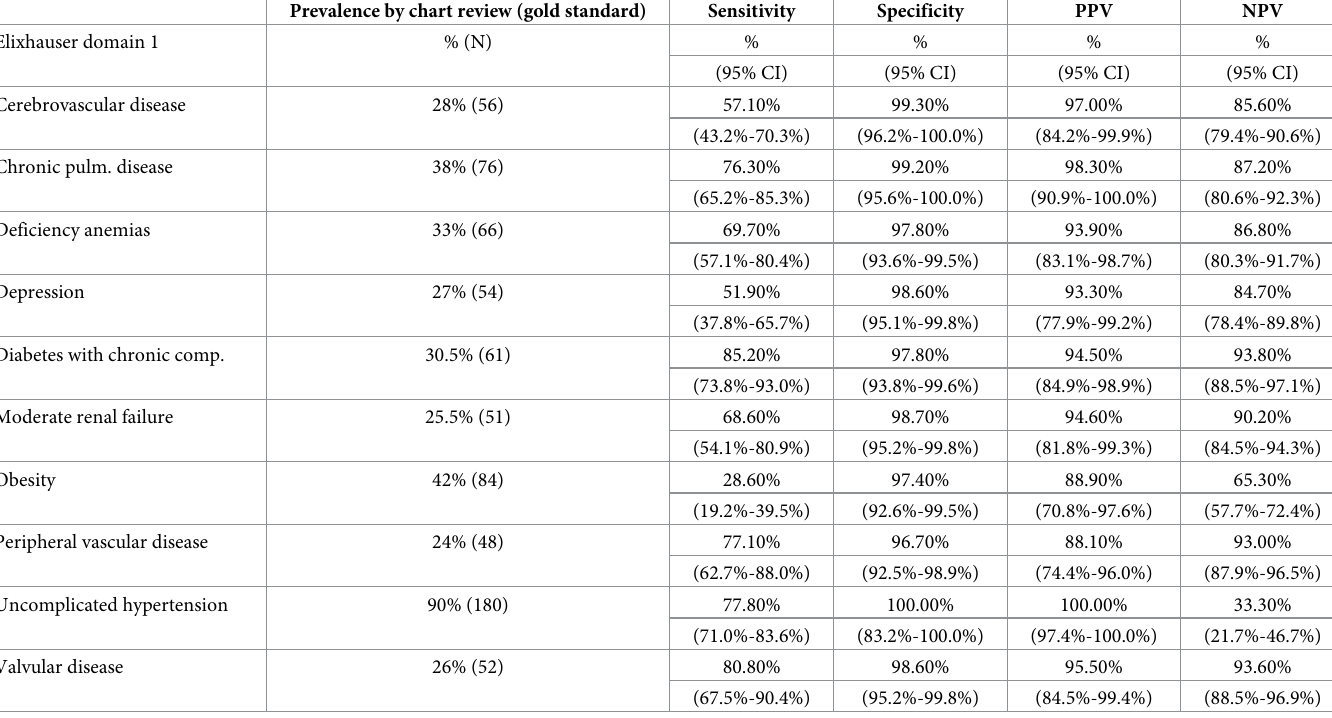
Table 2. Diagnostic accuracy of measuring Elixhauser comorbid domains from the EHR-based problem list for the ten most prevalent disease domains. Prevalence by chart review (gold standard) Sensitivity Specificity